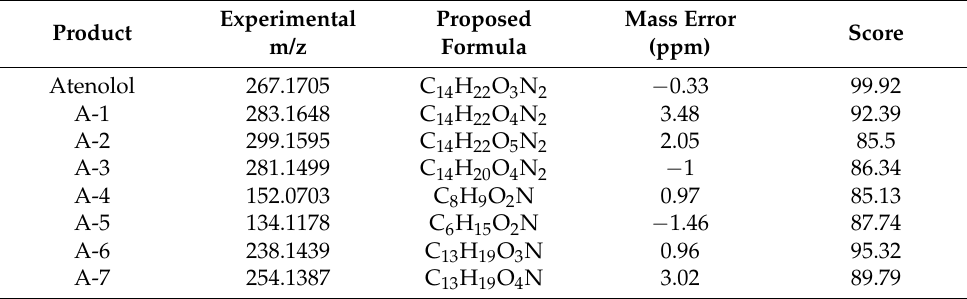
Table 1. List of ATL degradation compounds and their identification parameters. Experimental Product